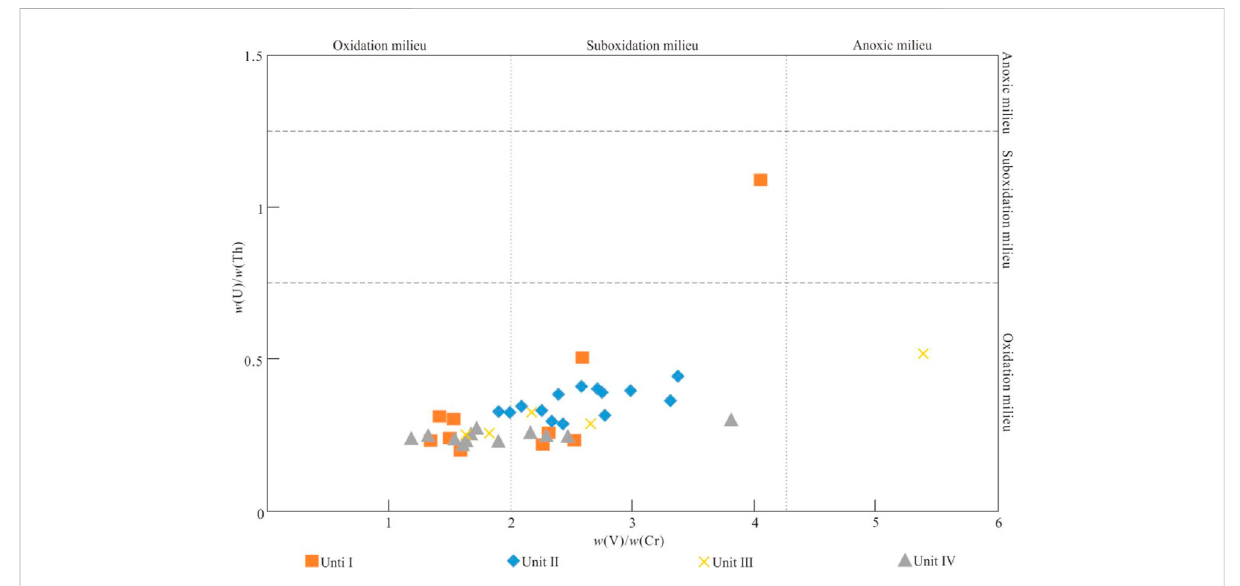
FIGURE 9 Intersection diagram of trace element ratio in the Da ’ anzhai